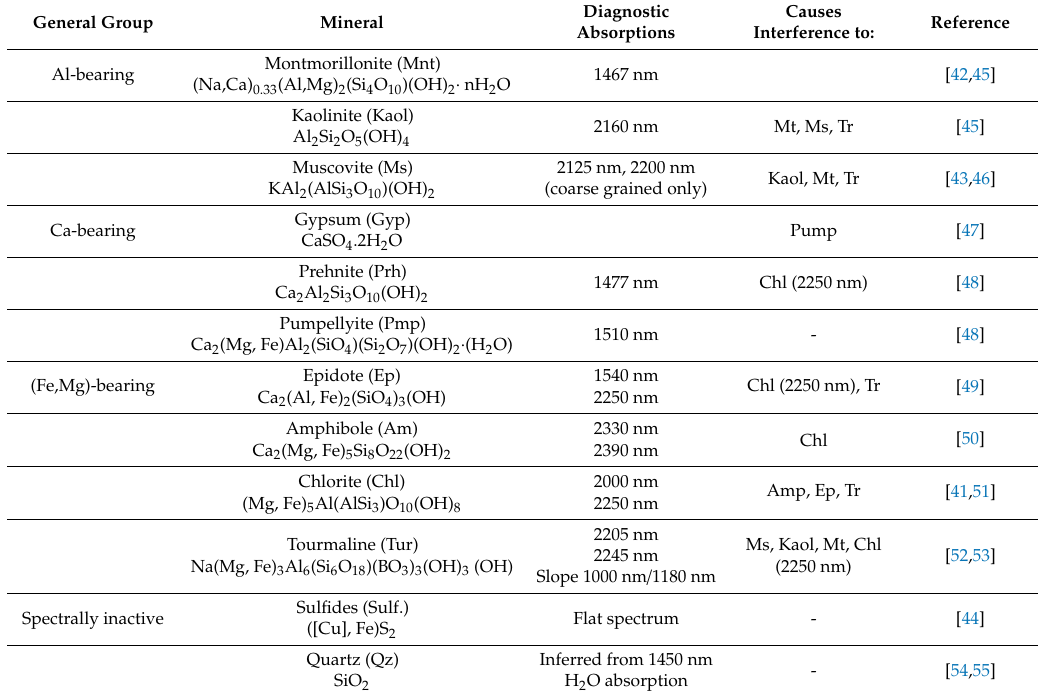
Table 1. Spectrally detectable mineralogy at Highland